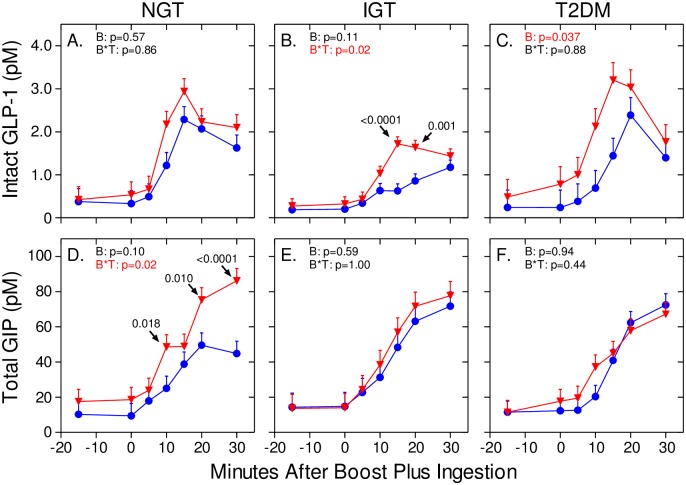
Bethanechol differentially affects GIP and GLP-1 responses in humans with NGT, IGT, and T2DM.Selected data from Fig 3 (-15 to 30 min) are expanded to emphasize differential GLP-1 (panels A-C) and GIP (panels D-F) responses to the 150 mg dose of bethanechol.